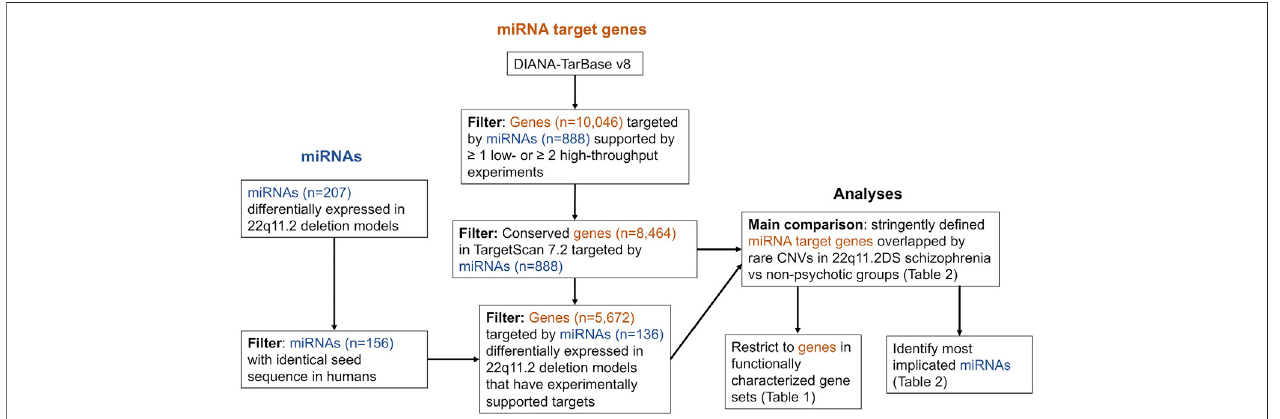
FIGURE2| Integratedwork fl owfortheretrievalofmicroRNAs(miRNAs)withevidenceofdifferentialexpressionin22q11.2deletionexperimentalmodels, fi lteringof experimentally supported miRNA target genes from DIANA-TarBase v8 (Karagkouni et al., 2018),and analysescomparing theproportion ofindividualsbetween groups with a miRNA target genes overlapped by an additional rare CNV. Each miRNA may target multiple genes and each gene may be targeted by multiple miRNAs.